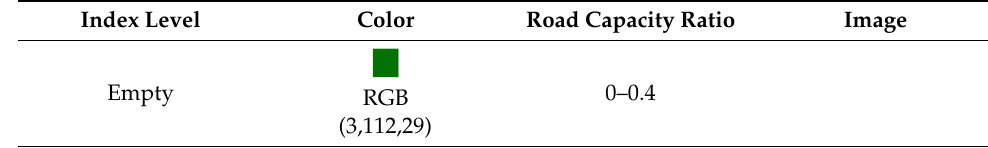
Table 11. Urban road vehicle traffic index